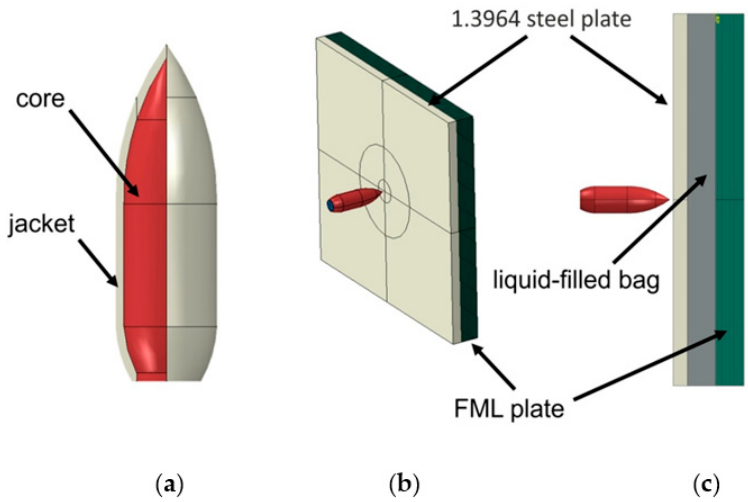
Figure 5. Geometry of the problem: ( a ) projectile, ( b ) model without a fluid ‐ filled bag, ( c ) model consisted a fluid ‐ filled bag between FML and steel plates. consisted a fluid-filled bag between FML and steel plates.